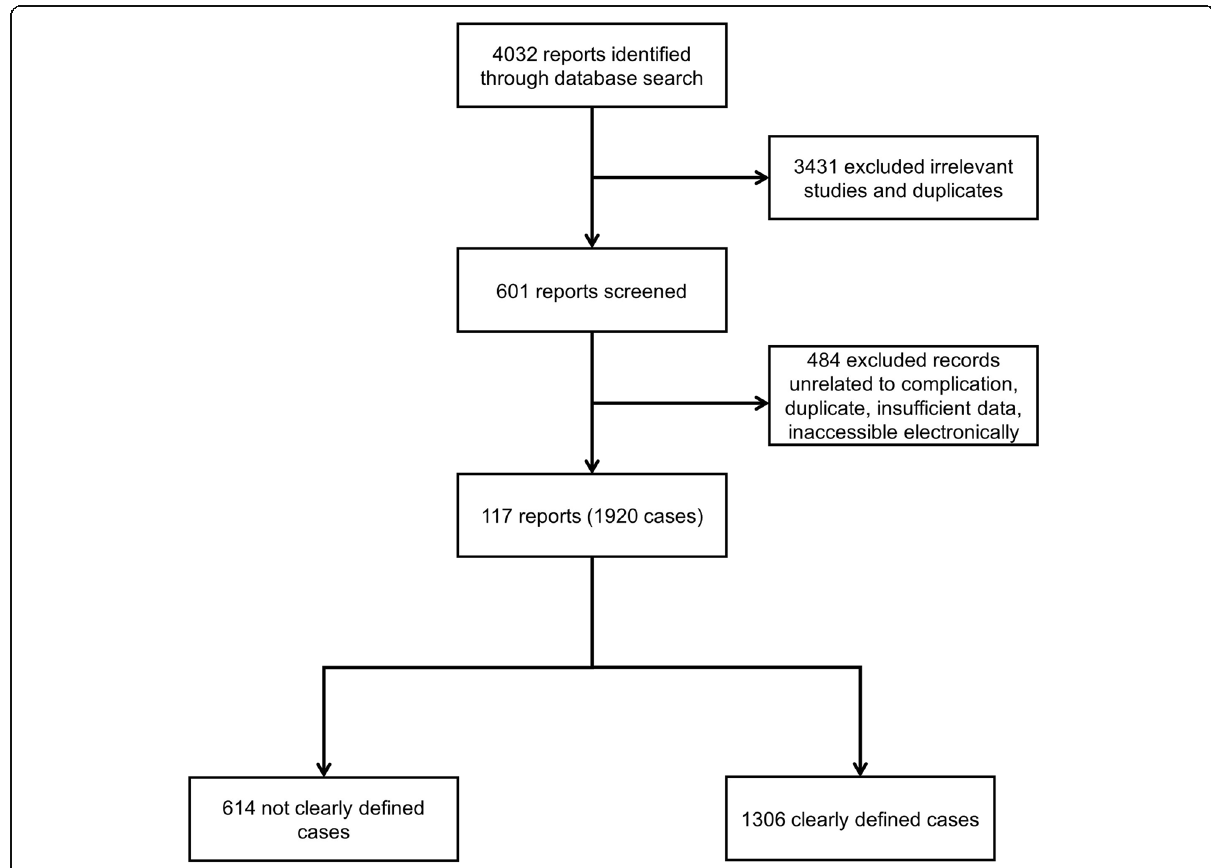
Fig. 3 Flow chart of the screening process for cinnarizine and